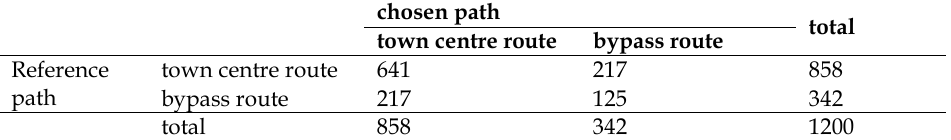
Table 3. RDSUE results with toll on the bypass – class-specific and total path flows